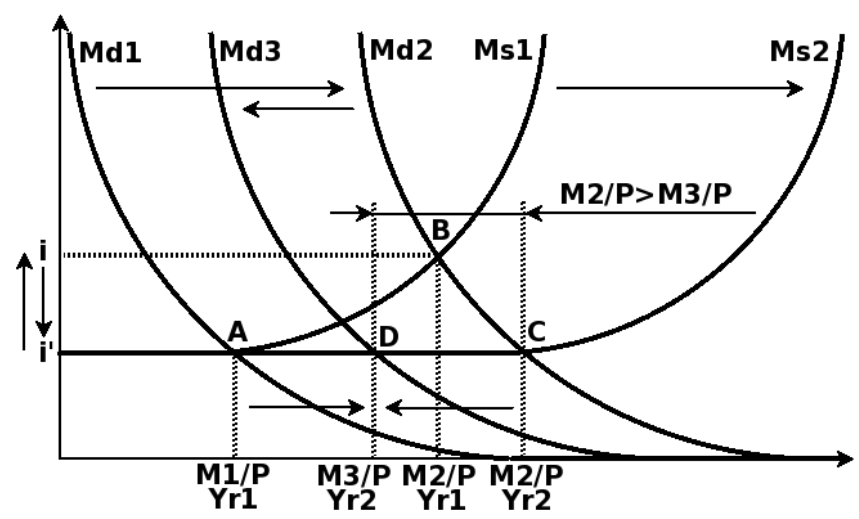
Figure 1. Demand, supply, and equilibrium in the money